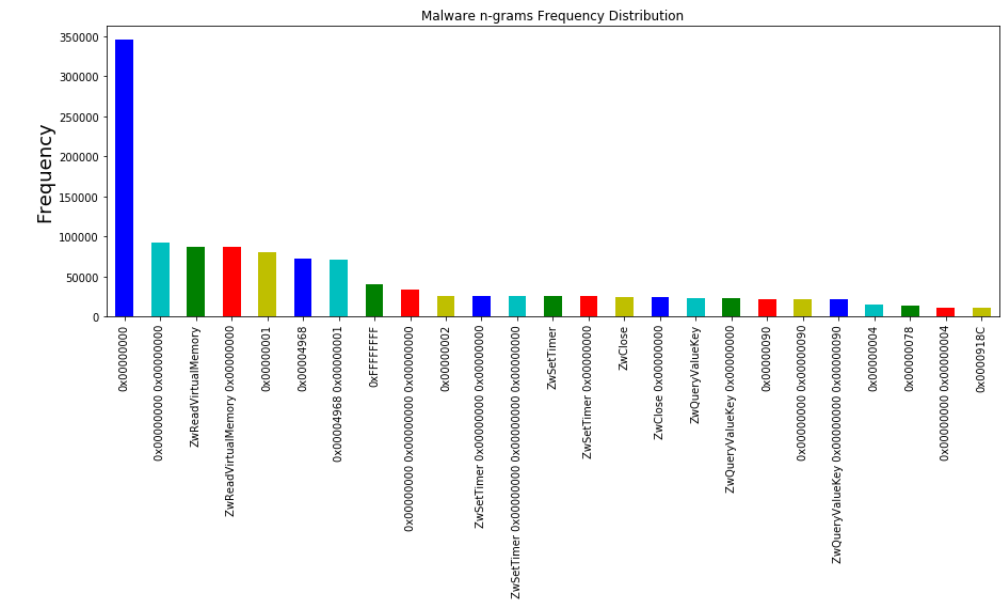
Figure 5. Malware API N-gram frequency distribution.